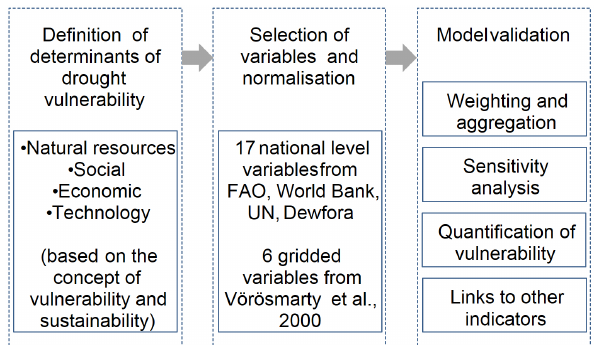
Fig. 1. Summary of the methodological